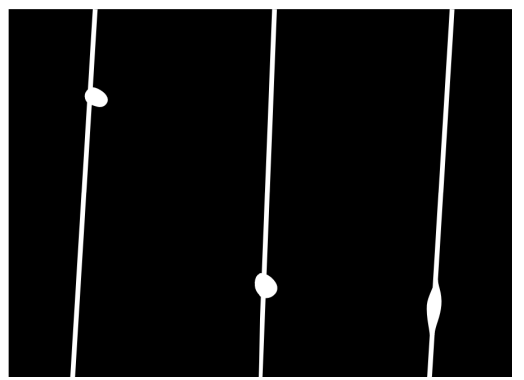
Figure 4. An example of a yarn image with a nep defect obtained using the image acquisition system (Adapted from [10]).